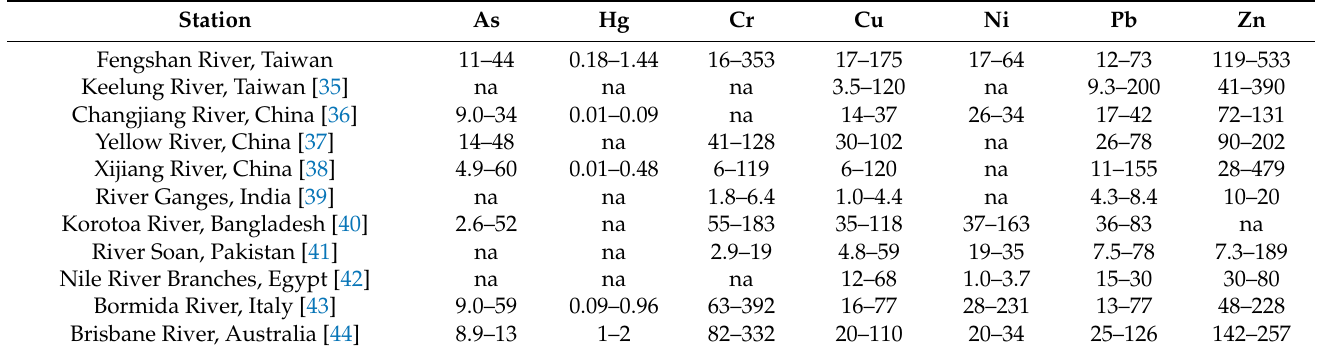
Table 2. Comparison among the heavy metal concentrations (mg/kg) of sediments in Fengshan River and those from other